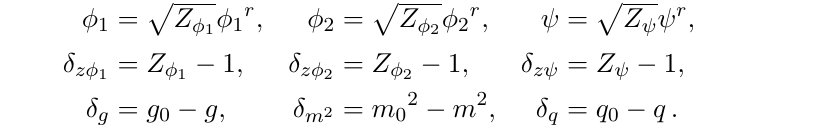
while scale invariance is broken. When d < z , the interaction terms in (2.9) and (2.10) are relevant and the quantum corrections are not divergent. When d > z the interactions are irrelevant and the quantum corrections diverge